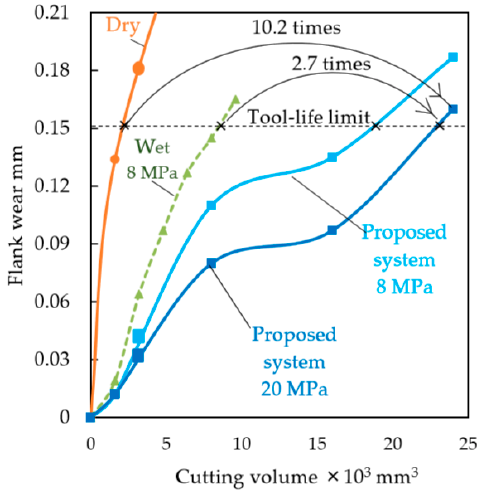
Figure 4. Experimental results of tool-life test.